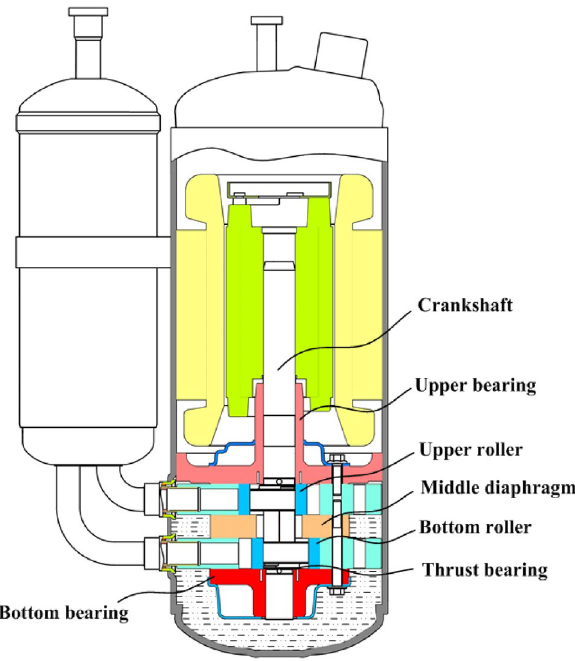
Figure 11. Schematic of test compressor.